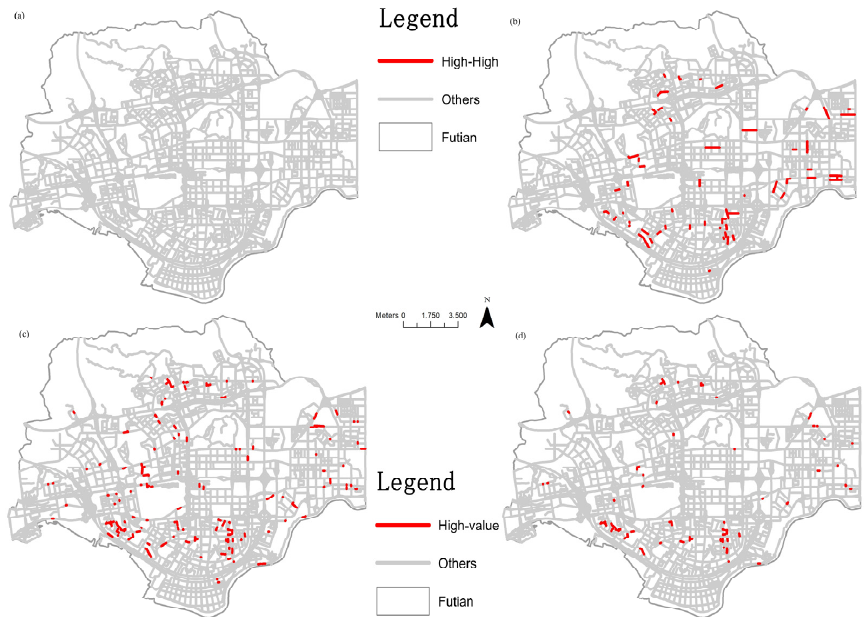
Figure 6. The results of local statistics: ( a ) ILINCS adjusted for the base distribution; ( b ) ILINCS using posterior risk and without adjustment for the base distribution; ( c ) GLINCS adjusted for the base distribution; ( d ) GLINCS using posterior risk without adjustment for the base distribution.